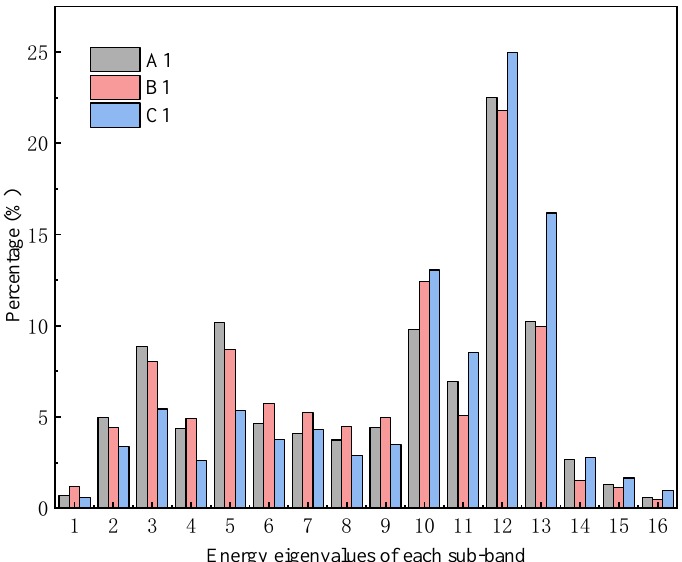
Figure 11. Percentage of energy in each frequency band of the P-signals.